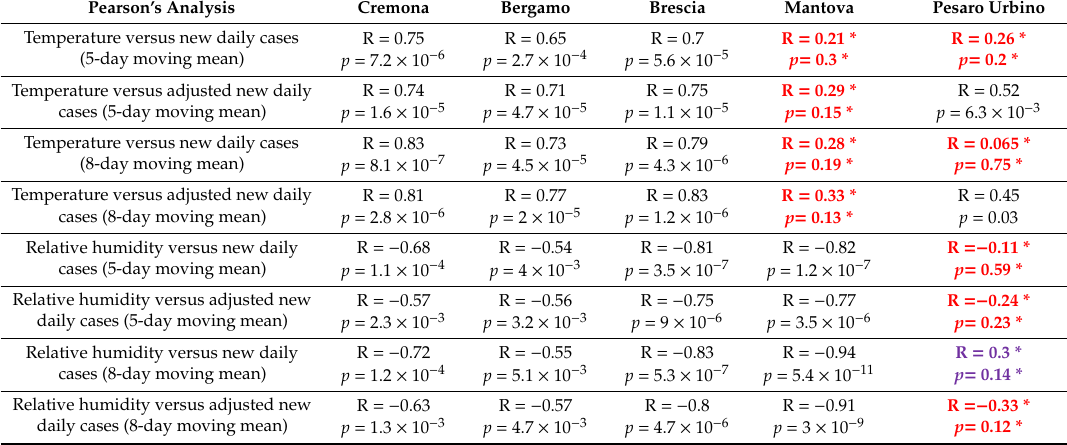
analyses over new daily cases of COVID-19 and meteorological parameters for five provinces of Italy